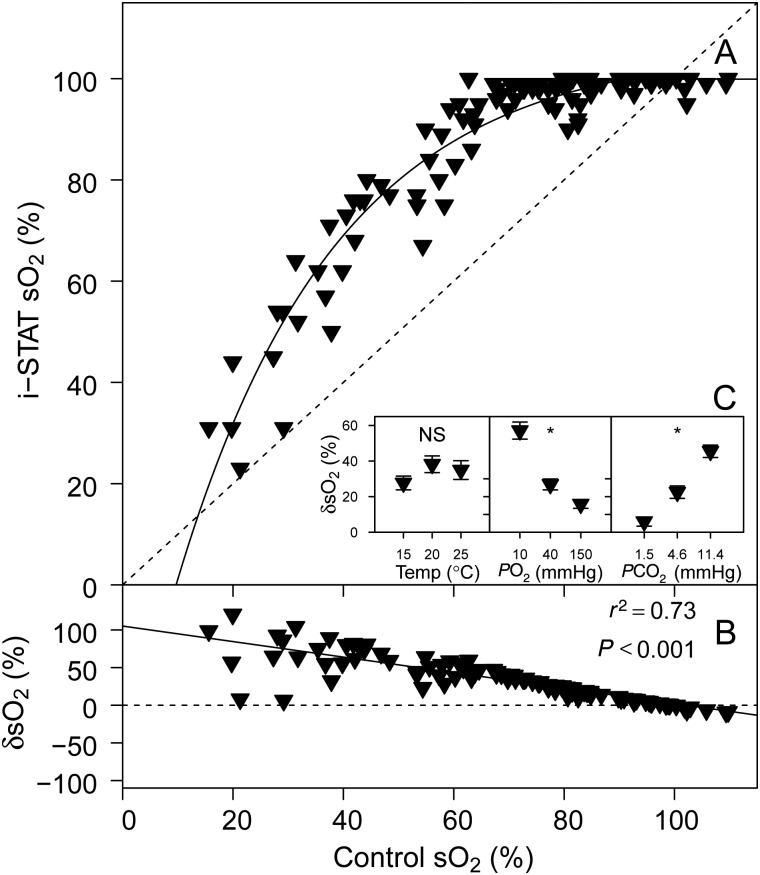
(A) Sandbar shark haemoglobin O2 saturation (sO2) measured with the i-STAT system vs. control sO2 measured according to Tucker (1967). (B) The relative error of i-STAT sO2 measurements, δsO2 vs. control sO2. (C) Effects of temperature, PO2 and PCO2 on δsO2. See legend to Fig. 1 for further information.